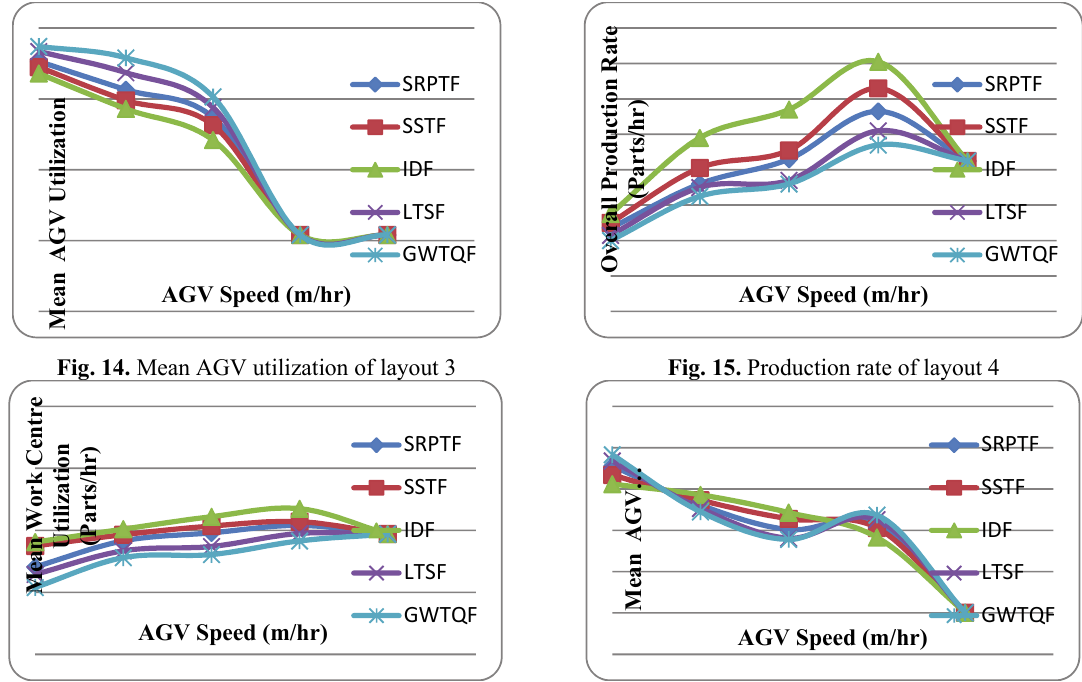
Fig. 16. Mean WC utilization of layout 4 Fig. 17. Mean AGV utilization of layout